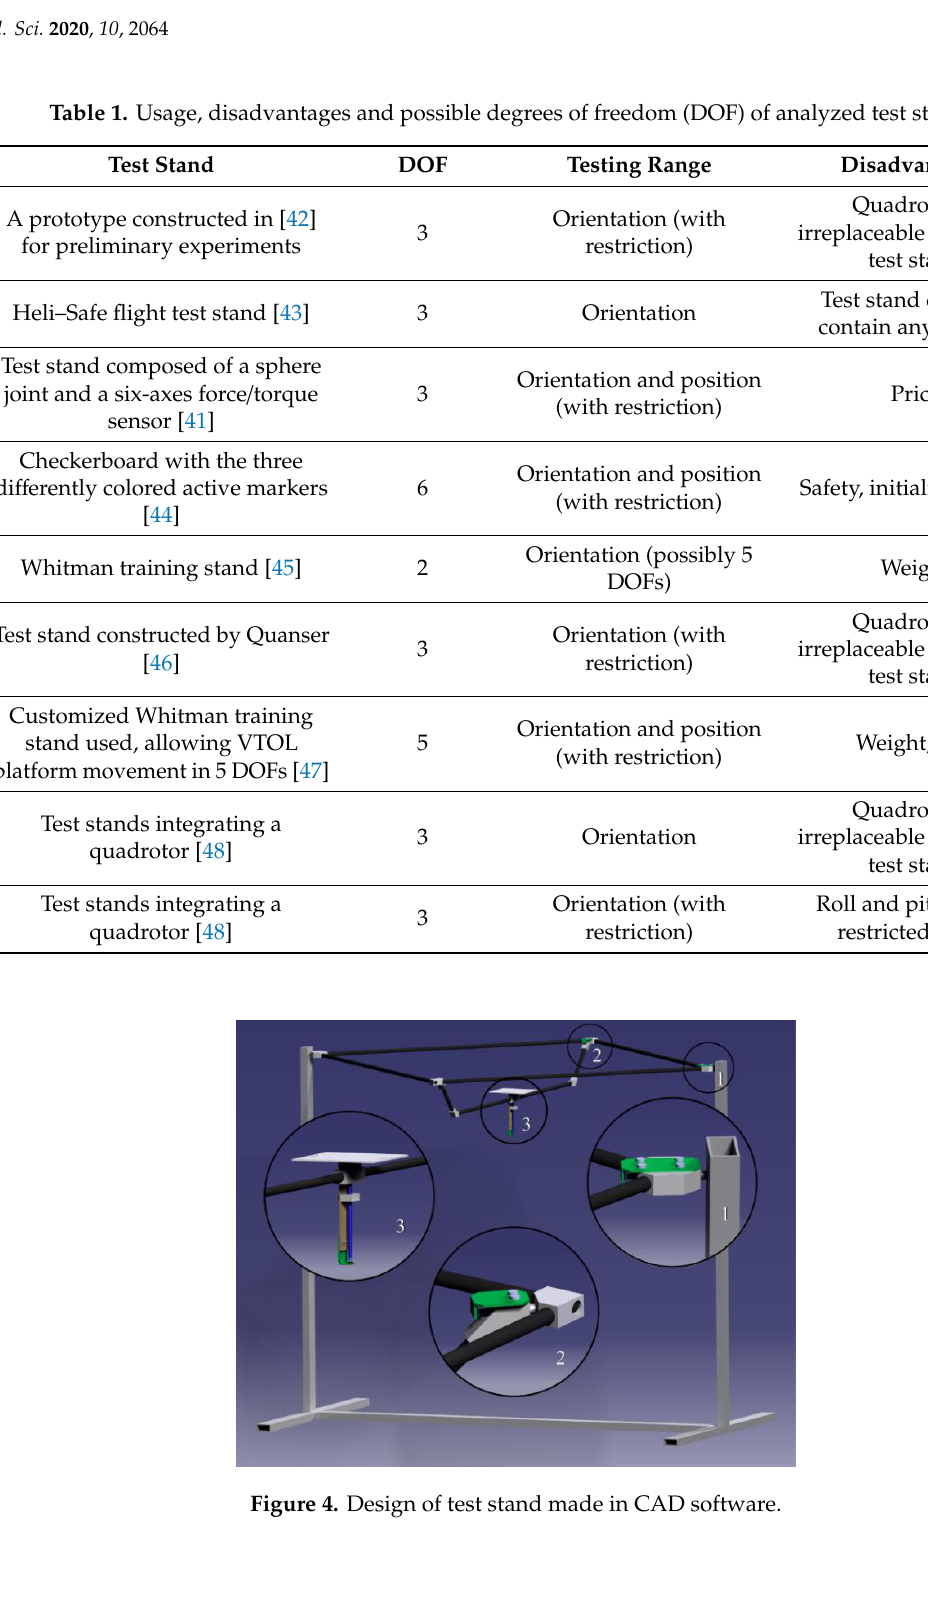
Figure 5. Prototype of the test stand. The communication scheme is shown in Figure 6. The stand was comprised of four modules, from which three are slaves used to measure orientation represented by blocks 1, 2 and 3 in Figures 4 and 5. The function of the fourth master module is to collect data from slave modules and send it to the superior system represented by block 5 in Figure 6. Modules communicate between each other